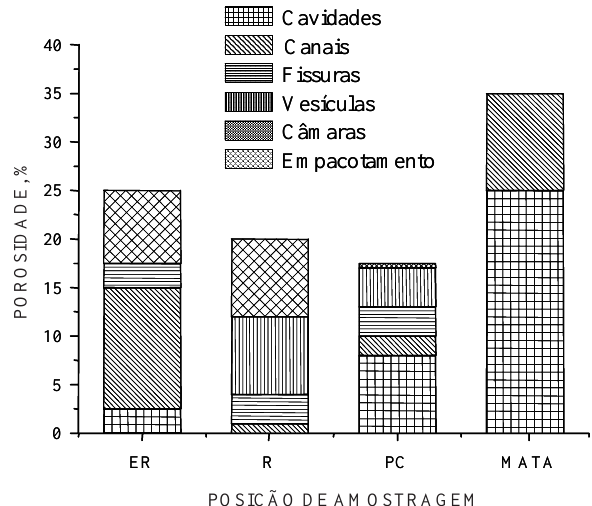
Figura 1. Tipos de poros e porosidade total nas diferentes posições de amostragem de um